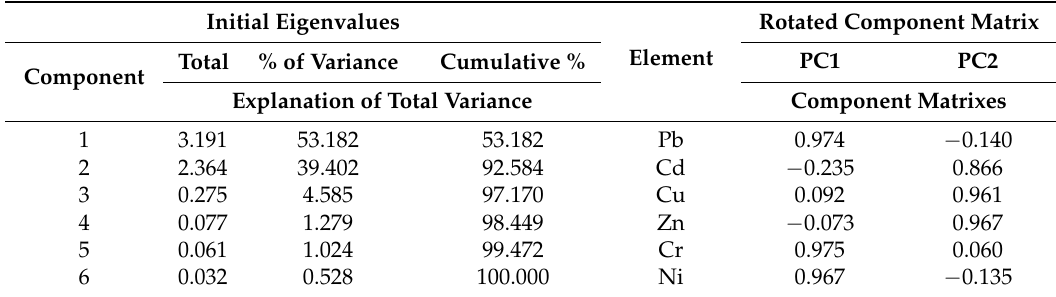
Table 3. Explanation of total variance and component matrix for trace metals in the topsoil. PC = principal component. Initial Eigenvalues Rotated Component Matrix Element Total % of Variance Cumulative % PC1 PC2 Component Explanation of Total Variance Component Matrixes